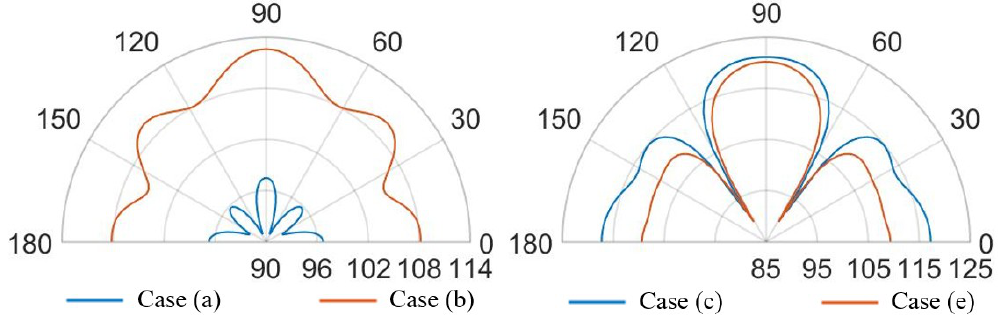
Figure 29. SPL polar plot (dB) at the performing fundamental frequency of 85.5 kHz (10 V bias), at 3.5 cm in the y(90 ◦ )–z(0 ◦ ) plane: (a) vs (b) ( left ), (c) vs (e) ( right ).